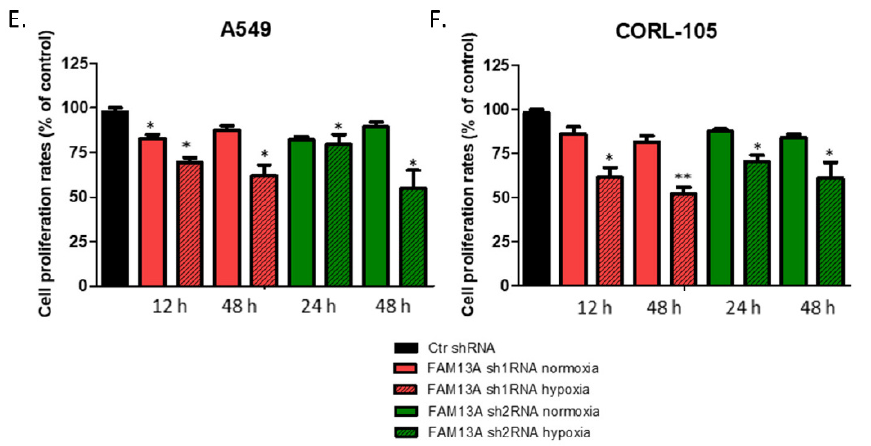
Figure 2. Silencing of FAM13A decreases lung cancer cell proliferation. Decreased A549 and CORL-105 cell proliferation after FAM13A gene knockdown was assessed using Violet Proliferation Dye (VPD450) and MTS test. After VPD450 staining the cells were cultured for 4–5 days in hypoxia and normal oxygen tension. The fluorescence intensity was measure by flow cytometry. During MTS test the cells were cultured in 96-well plates and cultured for two days in normal and hypoxic atmosphere. After 24/48 h the CellTiter 96 ® AQueous One Solution Reagent was added and the absorbance was read at 490 nm with a microplate reader. ( A ) Representative images of A549 cells stained with VPD450. Fluorescence intensity was measured from Day 1 (0 time point) to 5 (96 h time point) by flow cytometry (Flow Sight ® , Amnis, Seattle, WA, USA). Each cell is represented by a row of three images acquired simultaneously in flow, from left to right: channel 1—brightfield (gray), channel 2—fluorescence from GFP (transduced cells green) and channel 7—fluorescence from dye VPD450 applied to viable cells (purple). ( B ) Representative histogram plots displaying changes in VPD450 fluorescence intensity of A549 cells upon FAM13A knockdown (FAM13Ash1, red) and control (CtrNT2, green), in three time points: 0 h, 48 h, 96 h. ( C , D ) Cell growth kinetics was determined by proliferation index (PI) of FAM13Ash1 (red), FAM13Ash2 (green) and CtrNT2 (black), CtrSCR (grey) control cells in A549 ( C ) and CORL-105 ( D ). The difference in PI ratios at 24 h, 48 h, 72 h between FAM13A depleted cells and control cells was evaluated under normoxia ( left panel) and hypoxia ( right panel). A two-way ANOVA with Bonferroni posttest was used for statistical analysis. * p < 0.05 indicates a significant difference, as marked by an asterisk. The experiments were performed in triplicate and repeated three times. ( E , F ) Cell proliferation assessed by MTS assay. The results are given for A549 ( E ) and CORL-105 cells ( F ). Cell proliferation rate of FAM13Ash1 (red), FAM13Ash2 (green) cells and control cells (mean combined for CtrNT2 and SCR, black) was determined by CellTiter™ AQueous assay (MTS). The difference in cell proliferation rate of FAM13A depleted cells compared to control cells was evaluated under normoxia (bars without filling) or hypoxia (bars with texture) conditions. Data are means ± SEM (n = 4), * p < 0.05, ** p < 0.01, two-way